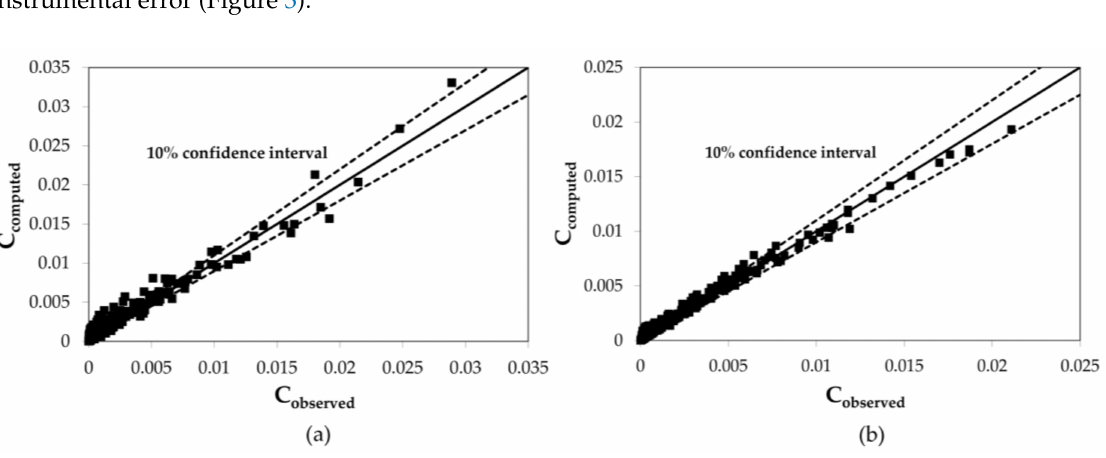
Figure 3. Observed vs. computed concentrations (simplified entropic model): ( a ) Valiani’s data and ( b ) Coleman’s